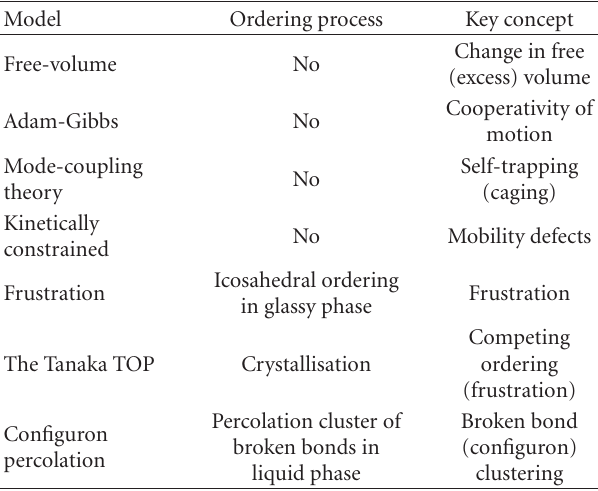
Table 5: Basic glass transition